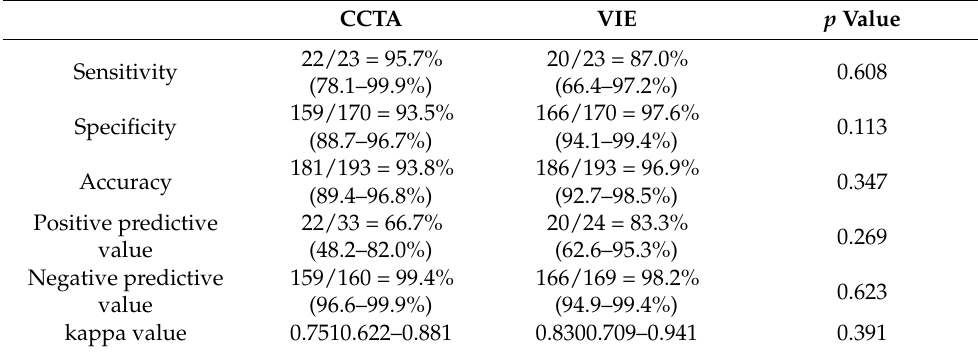
Table 2. Diagnostic performance of CCTA versus VIE in detecting in-stent restenosis in 193 stented vessels, using ICA as the gold